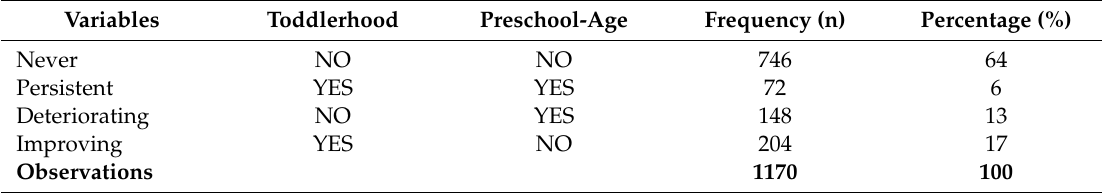
Table A6. Evolutionary path from toddlerhood to